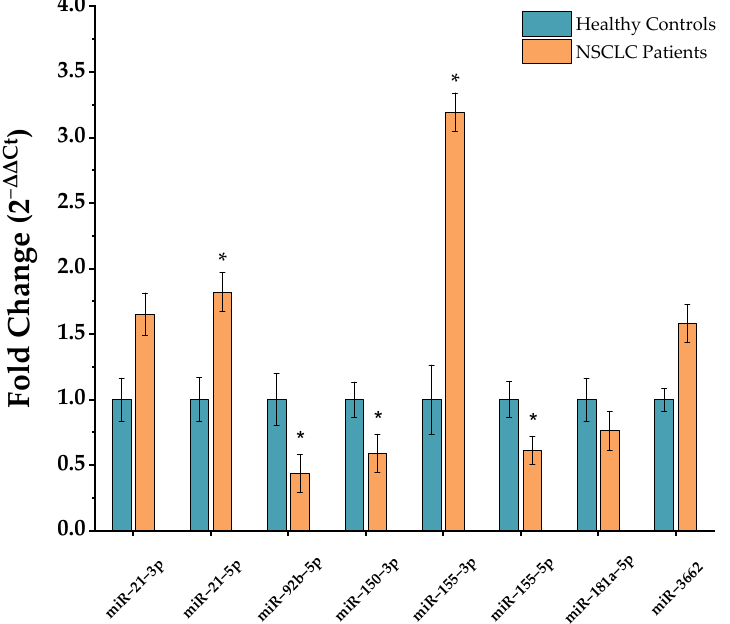
Figure 1. Selected-miRNA relative expression in NSCLC and healthy control PBMCs. Data were normalized to housekeeping miRNAs 103a-3p and 191-5p, and further NSCLC miRNA expression calculated relatively to a healthy control expression value of 1 (mean ± SD, * p < 0.05). Data population after outlier exclusion for multiple miRNAs was: miR-21-3p (control n = 19, NSCLC n = 23); miR-21-5p (control n = 21, NSCLC n = 50); miR-92b-5p (control n = 20, NSCLC n = 45); miR-150-3p (control n = 19, NSCLC n = 45); miR-155-3p (control n = 20; NSCLC n = 45); miR-155-5p (control n = 12; NSCLC n = 21); miR-181a-5p (control n = 10, NSCLC n = 18); and miR-3662 (control n = 10; NSCLC n = 18). As such, miR-21-5p, which is also over-expressed in the model A549 NSCLC cell line with a 2.03-fold change compared to MRC-5 normal lung cell line (Figure S1), was